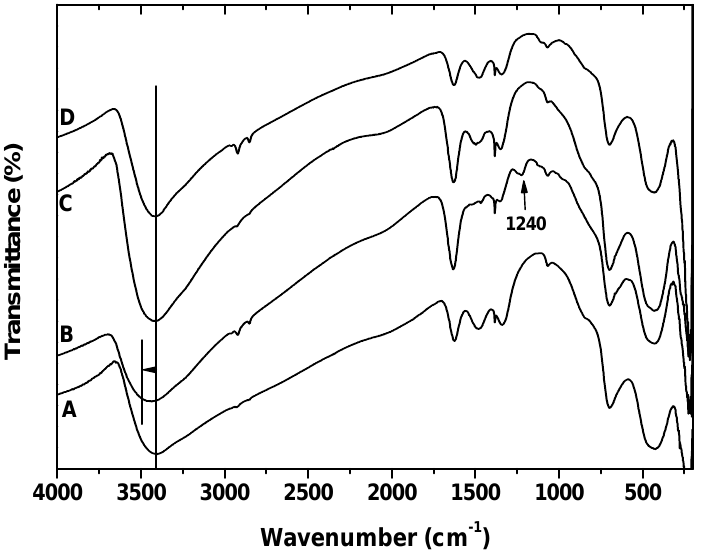
Figure 4. FTIR spectra of ( A ) Akaganeite (Ak); ( B ) Α k after SDS adsorption; ( C ) Ak after CTAB adsorption, and Ak after tween80